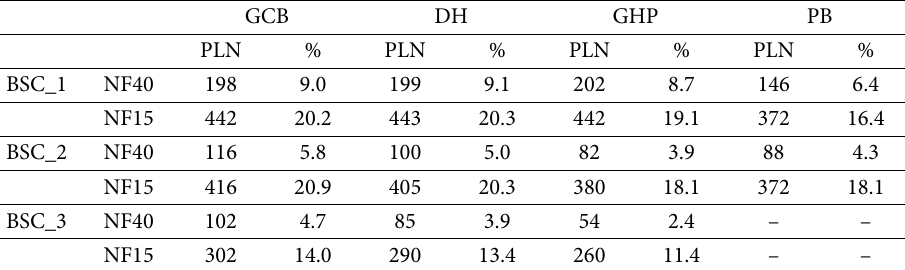
Table 5. Rise in investment costs [PLN/m 2 /a] necessary to implement NF40 and NF15 standards for the analyzed buildings and heat sources with reference to the requirements in force in 2013 in Poland, 1 Euro = 4.20